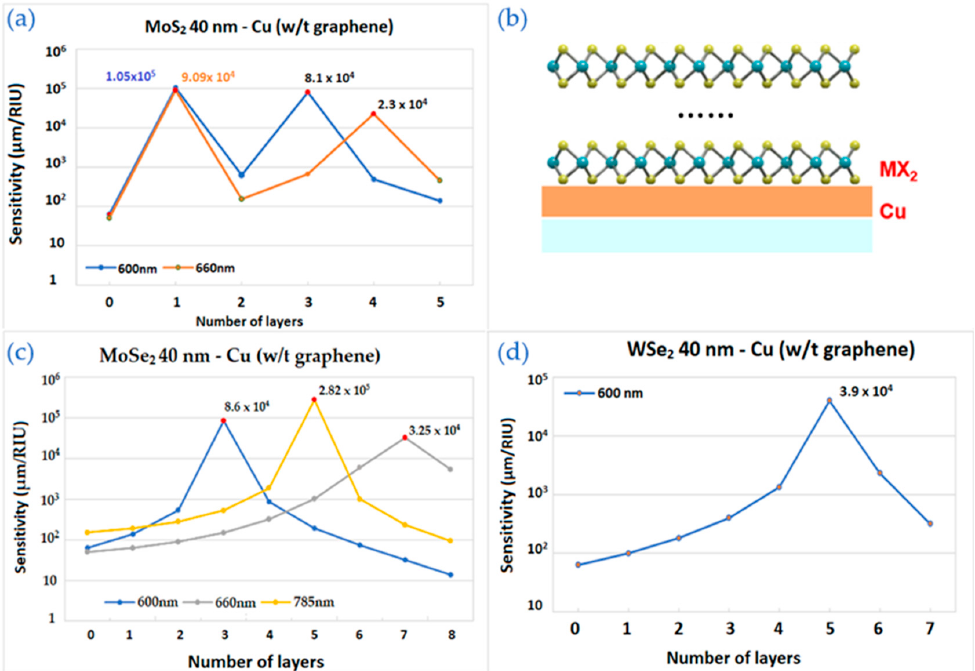
Figure 4. The sensitivity values of the enhanced model by number of TMDC layers with 40 nm of copper: ( a ) The wavelengths are 600 nm and 660 nm for MoS 2 layers; ( b ) the schematic structure; ( c ) The wavelengths are 600 nm, 660 nm, and 785 nm for MoSe 2 layers; ( d ) The wavelength is 600 nm for WSe 2 layers and 40 nm of Cu.